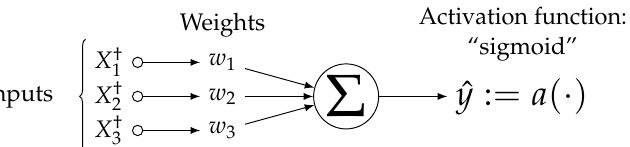
Figure 5. The above architecture presents a feed forward neural network with three input variables. , X † , X † , which are variable modules created using Equation (6). The input variables are X † 2 3 } 1 {